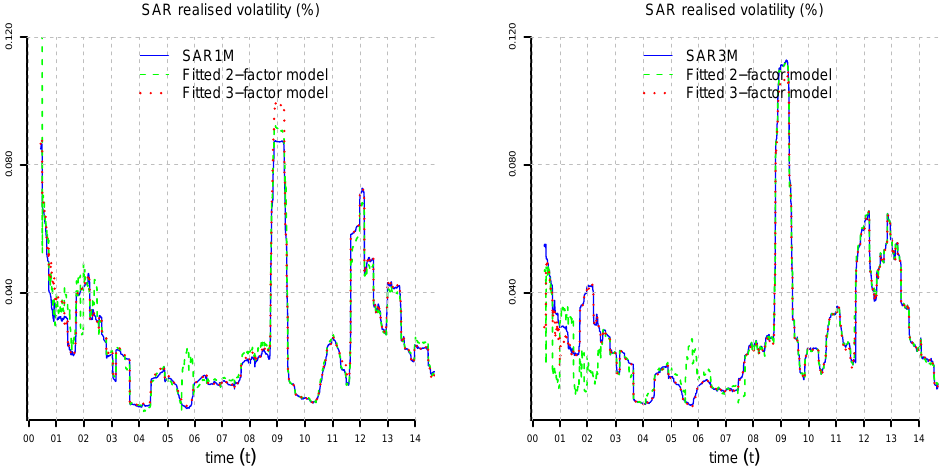
(cid:92) Figure 10. SAR realized volatility RCov ( t , τ , τ ) 1 2 for K = 126, τ = 21 (lhs), τ = 63 (rhs) and all observation dates compared to the realized volatility of the two- and three-factor Vasiˇcek models fitted by optimization (23) for M = 6, τ 1 = 1, τ 2 = 2, τ 3 = 5, τ 4 = 10, τ 5 = 21, τ 6 = 63 and w ij = 1 { i = j }